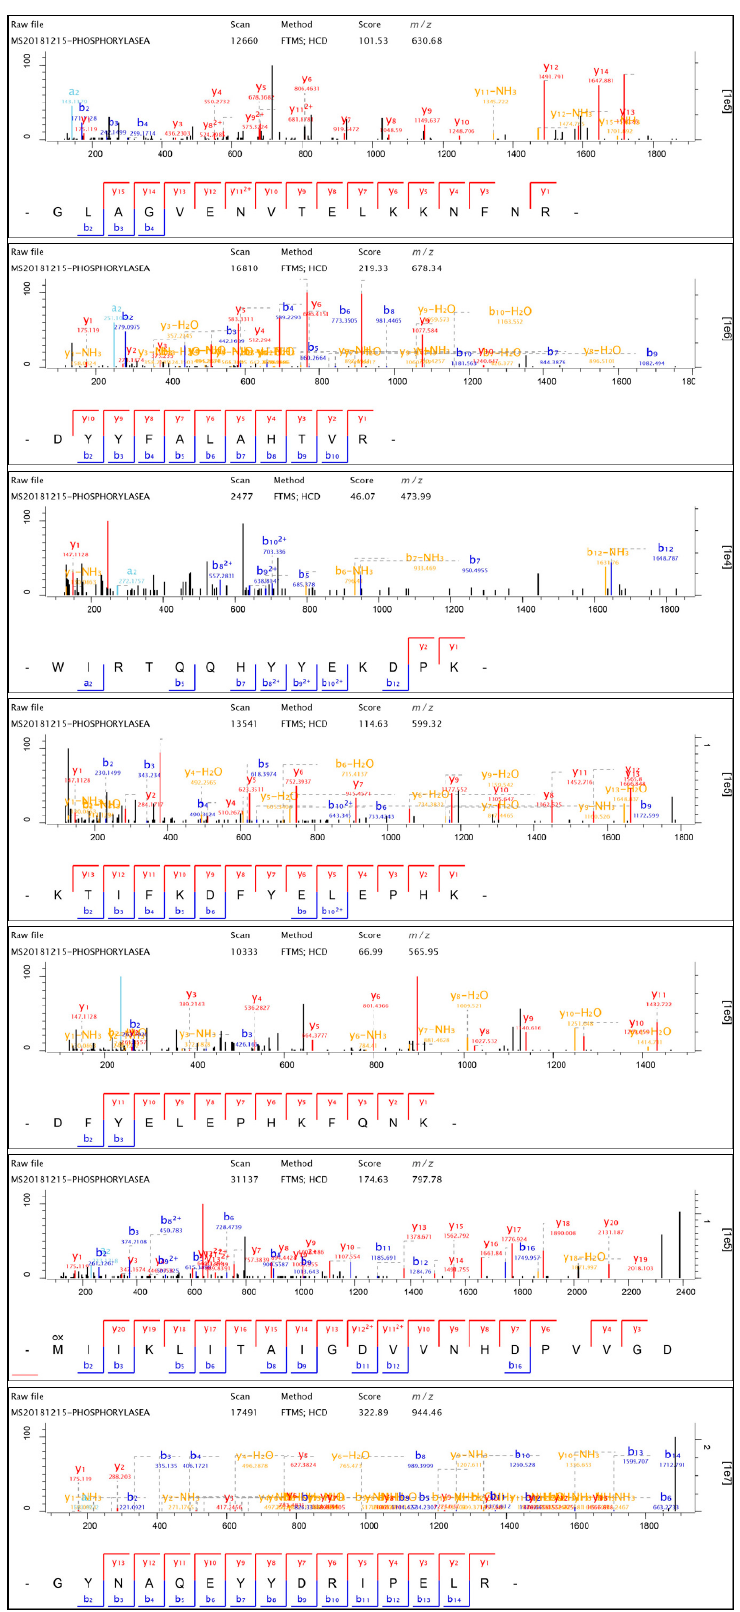
Figure 6. LC-MS/MS analysis of the Alpha-1,4 glucan phosphorylase (Glycogen phosphorylase, muscle form) labeled by probe 1